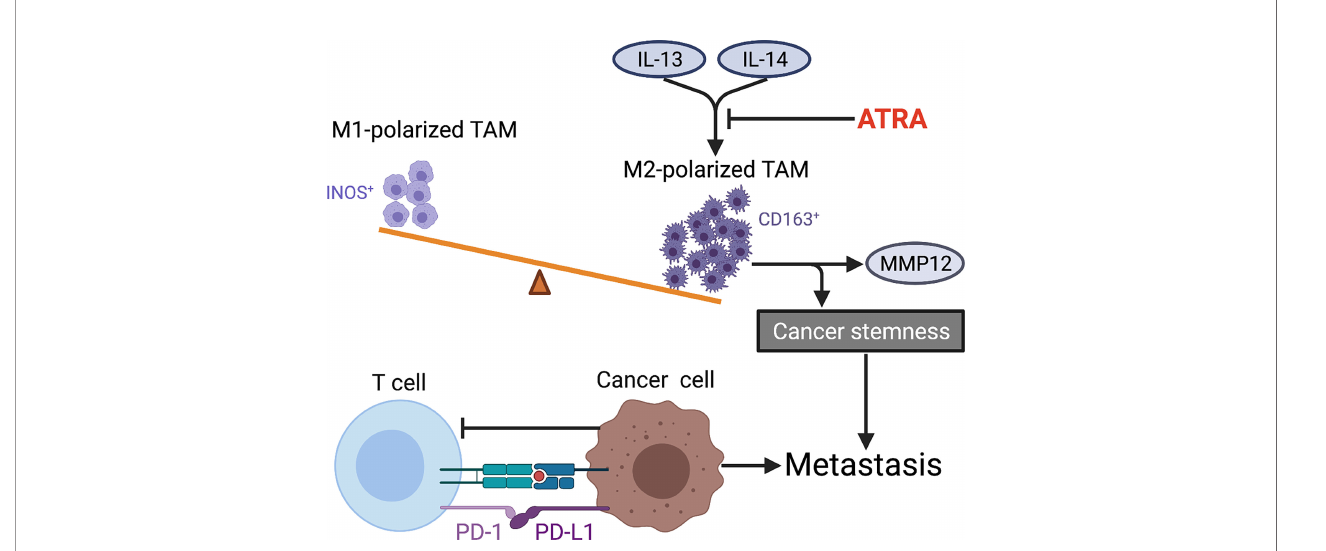
FIGURE 5 | Tumor immune microenvironment characteristics within OS metastasis. The imbalance of M1 (INOS + )/M2 (CD163 + )-polarized TAMs in favor of M2 subtype is observed in metastatic OS. ATRA suppresses IL-13-induced secretion of MMP12 from M2-polarized macrophages and also weakens cancer stemness by preventing M2 polarization of TAMs in OS. The interaction between PD-L1 (expressed in metastatic OS cells) and PD-1 (expressed in tumor-in fi ltrating CTLs) limits antitumor function of T cells and thus promotes OS metastasis by evading immune surveillance. TAMs, tumor-associated macrophages; ATRA, all-trans retinoic acid; PD-L1, programmed death ligand 1; PD-1, programmed death receptor-1; CTLs, cytotoxic T